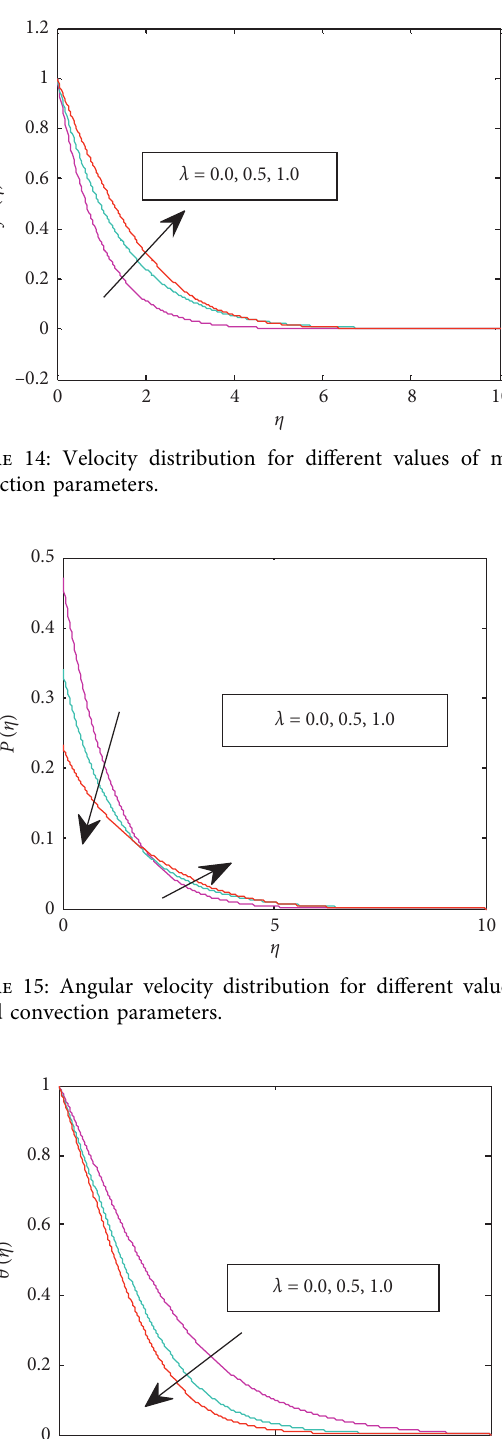
Figure 13: Temperature distribution for different values of couple stress parameters.